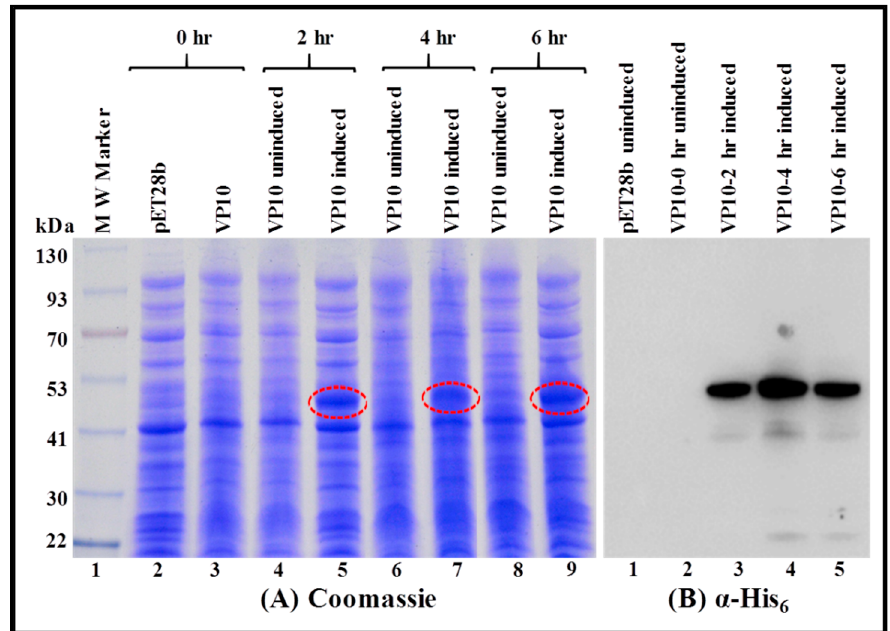
Figure 6. Sub-optimal expression of the recombinant FIV full-length Pr50 Gag -His 6 -tag fusion protein in soluble fraction of Escherichia coli ( E. coli ). Bacterial cells transformed with VP10 were grown at 37 ◦ C and induced with IPTG. This was followed by growing the cultures sub-optimally for varying time points at 28 ◦ C in the presence of 1% glucose. ( A ) Coomassie Brilliant Blue-stained electrophoresed gel confirmed expression of a full length Pr50 Gag -His 6 -tag fusion protein from VP10 in the soluble fraction. ( B ) Western blot analysis on the same soluble fraction from bacteria containing Pr50 Gag -His 6 -tag fusion protein using α -His 6 monoclonal antibody.